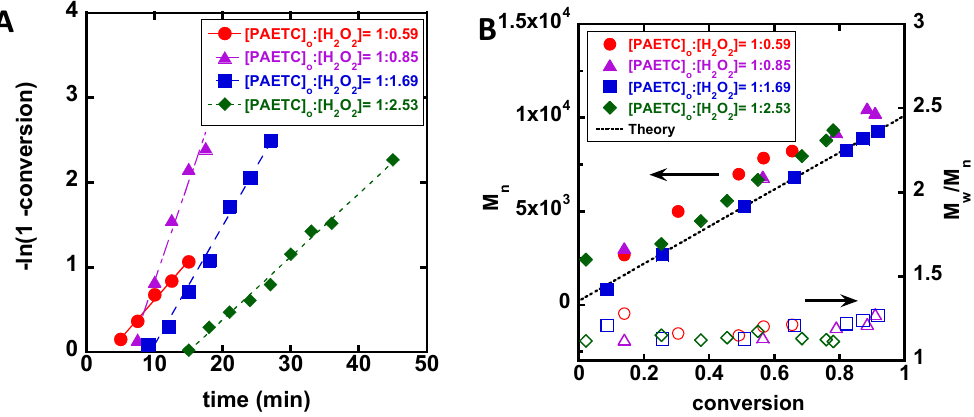
Figure 3. ( A ) Semilogarithmic plots and ( B ) evolution of M n (solid point) and M w /M n (open points) of HRP-catalyzed polymerization. Red points (circles) show [PAETC] 0 :[H 2 O 2 ] = 1:0.59. Purple points (triangles) show [PAETC] 0 :[H 2 O 2 ] = 1:0.85. Blue points (squares) show [PAETC] 0 :[H 2 O 2 ] = 1:1.69. Green points (diamonds) show [PAETC] 0 :[H 2 O 2 ] = 1:2.53. Component ratios utilized were [DMAm] 0 :[PAETC] 0 :[ACAC] 0 :[H 2 O 2 ] 0 = 100:1:9.7: X , and concentrations were [DMAm] = 170 mM, [HRP] = 0.71 mg/mL in 4.2 mL of pH = 5.5, 20 mM acetate buffer at 25 °C.